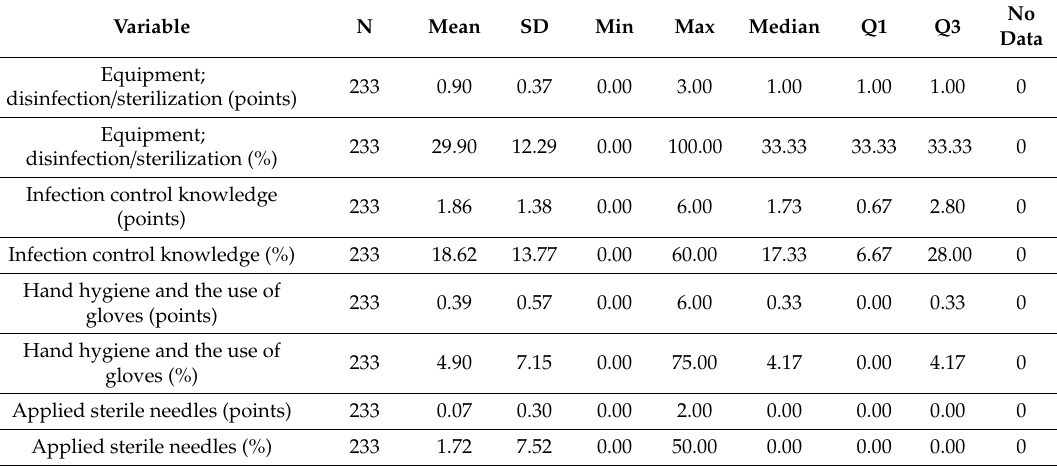
Table 5. Scoring of client risk according to particular areas or risk